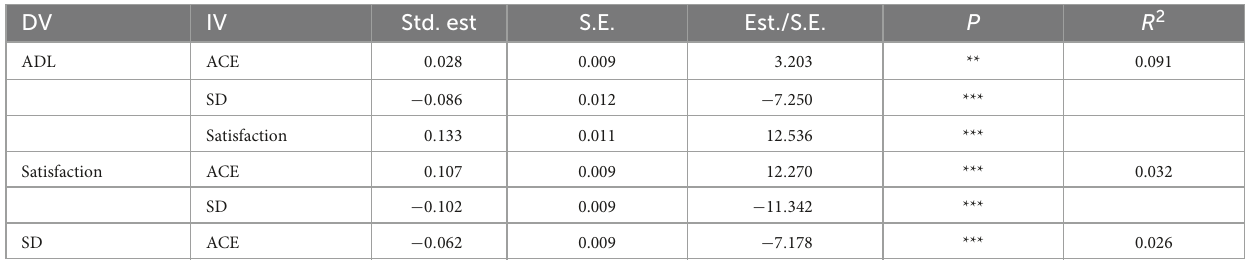
TABLE 7 Model regression weight of the impact of ACEs on ADL.